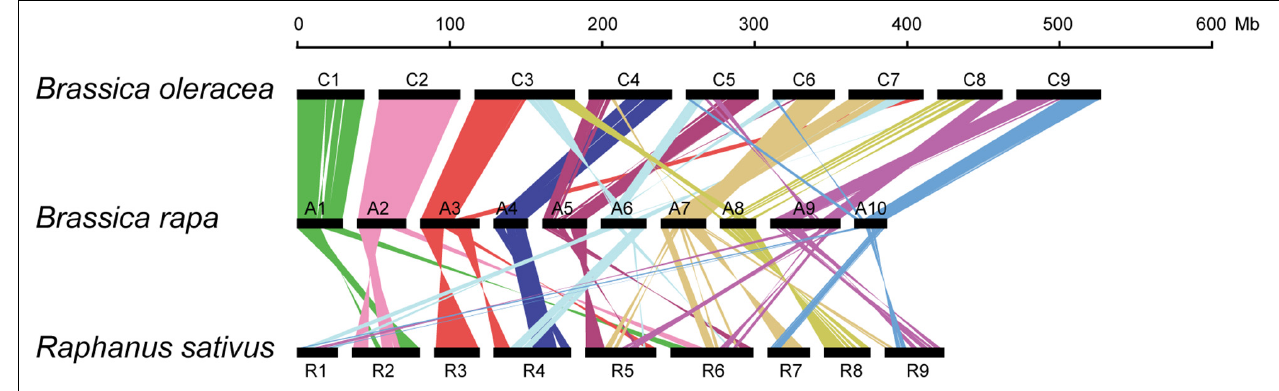
FIGURE 6 | Schematic representation of chromosomal synteny among B. rapa (A1–A10), B. oleracea (C1–C9) and R. sativus (R1–R9). Each pair of syntenic blocks is connected with colored